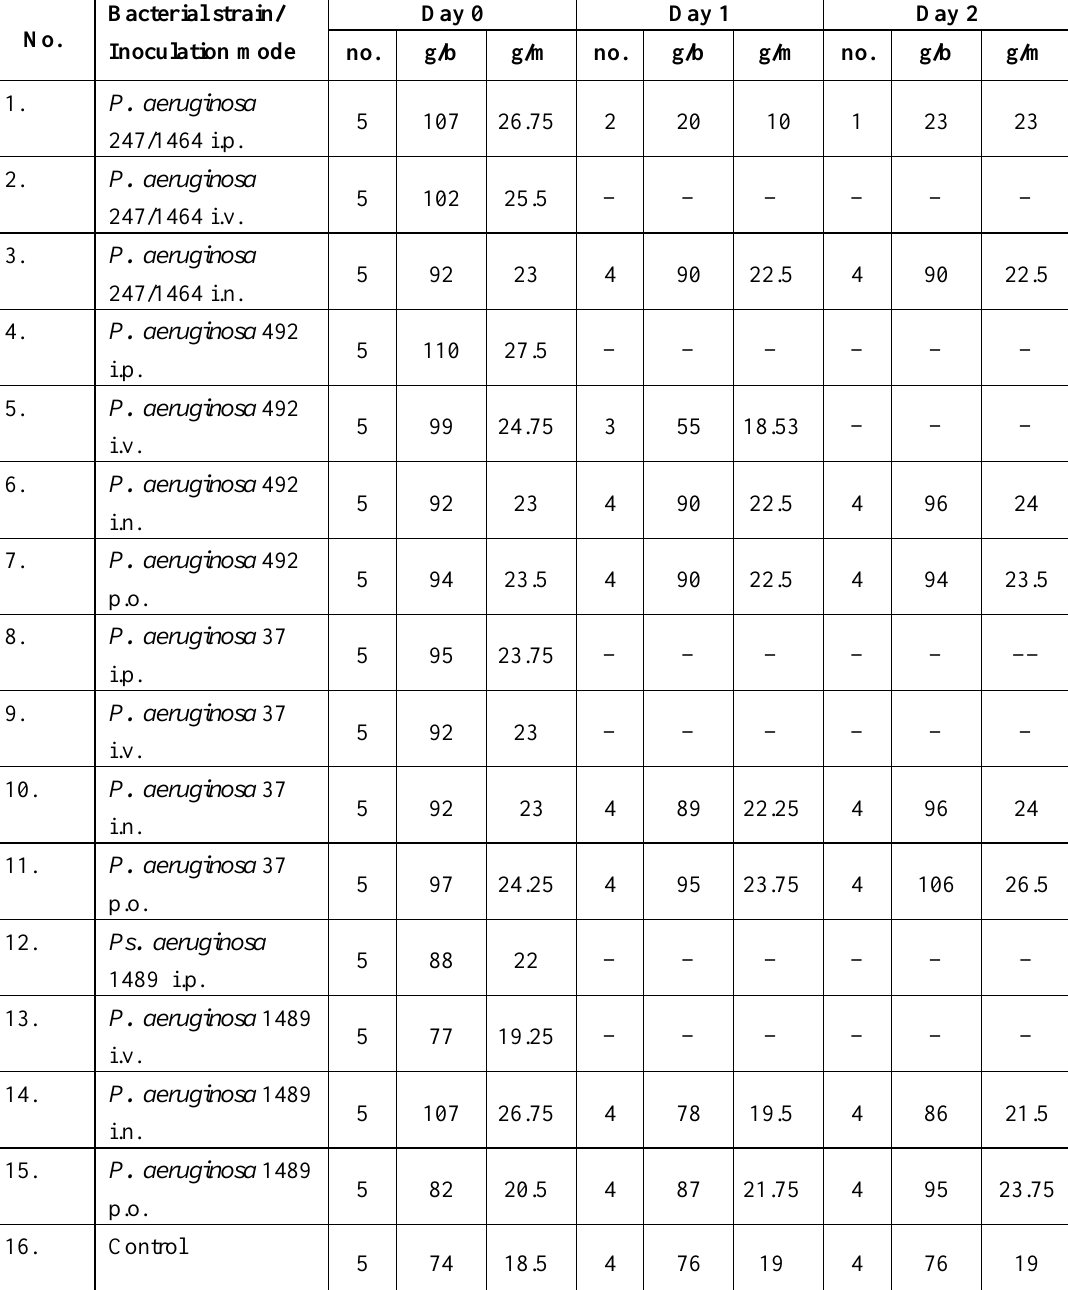
Table 1. Mortality and body weight dynamics in animals infected with P. aeruginosa wild